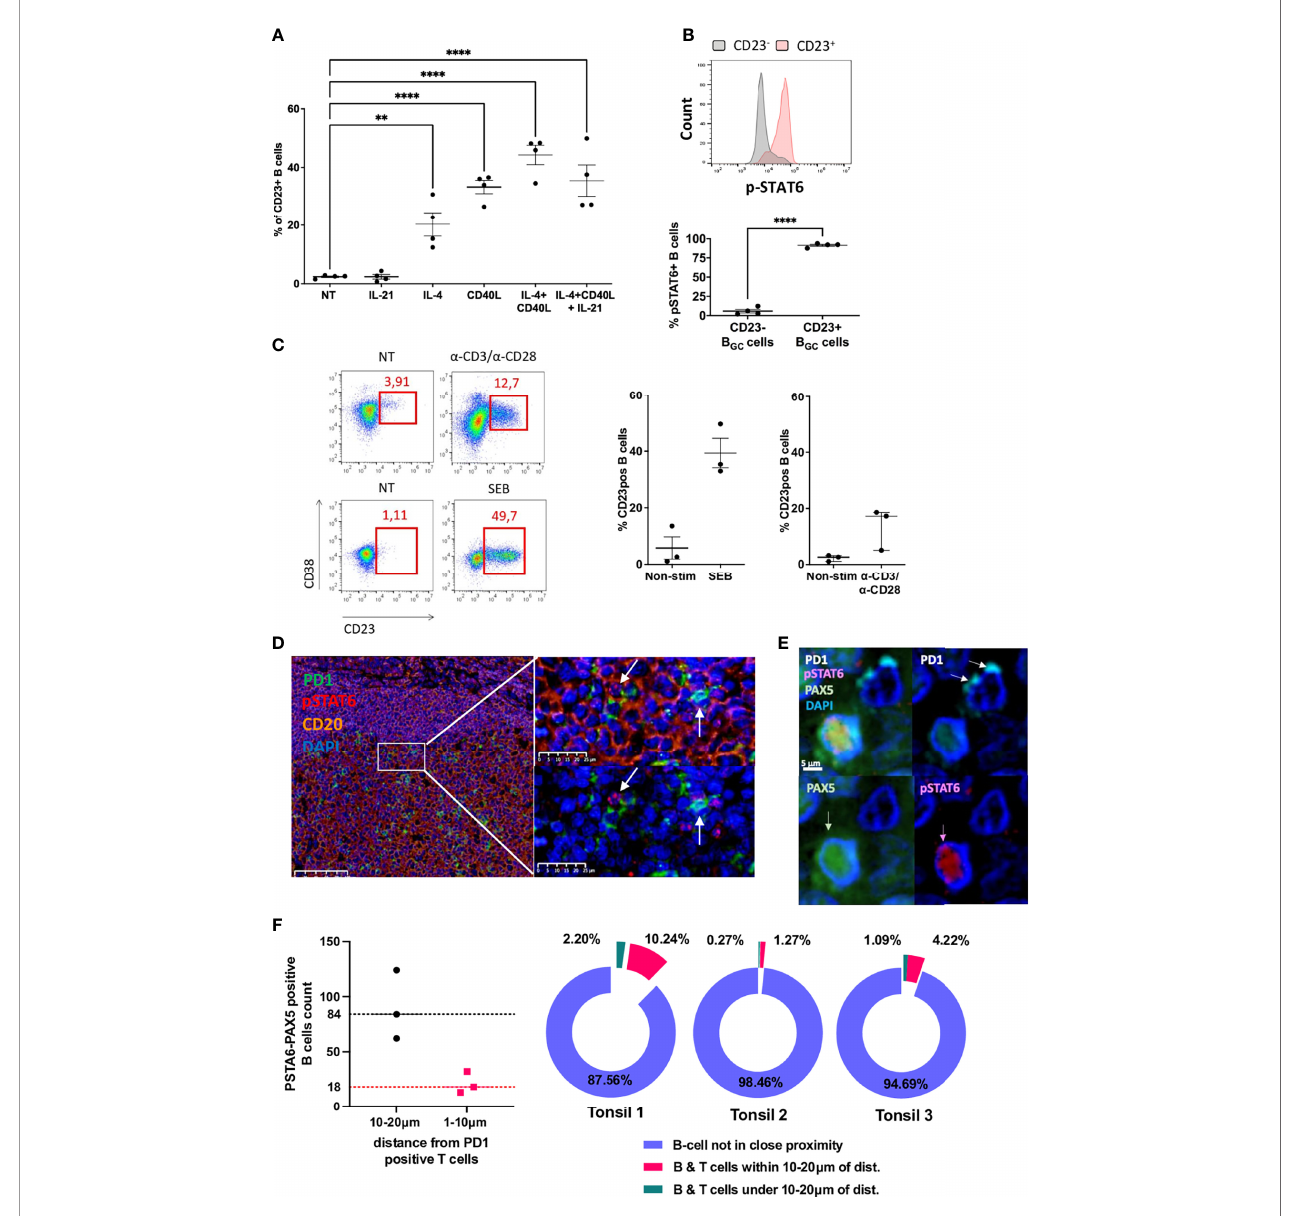
FIGURE 3 | CD23 expressionofLZB GC -cellsdependsonresponsetoTfh-drivenstimulation. (A) FlowcytometryanalysisofCD23 + LZB GC -cellsobtainedafter 12hofculture withIL-4,CD40LandIL-21aloneor incombinations(** P < .01;**** P < .0001; one-waymultiplecomparisonstest). (B) Flow cytometryanalysis ofpSTAT6inductiononpost- stimulationCD23 + andCD23 - LZB GC -cells, infourindependentexperiments: Upper panel,arepresentative fl owhistogram;Lower panel,quantitativeandstatisticallysigni fi cant analysis. (C) LZB GC -cells andTfhcells wereco-culturedwithouttreatment(NT) or withaCD3/aCD28 or staphylococcalenterotoxinB (SEB) proteinfor 24handsubsequently analyzed for CD23 and CD38 expression, using fl ow cytometry: left panel, representative fl ow graphs; right panel, results of three independent experiments. (D) GC immunohistostaining onparaf fi n-embeddedtonsilsectionswithDAPI(blue), CD20(yellow), PD1 (green), andpSTAT6(red) presentingtwohighmagni fi cationviews,showing pSTAT6 + BcellsintheproximityofPD1 + Tfhcells(whitearrows). (E) AnimagecompatiblewithacognateBcell-TfhcellcontactcharacterizedbypSTAT6 + Bcellincontactwith PD1 + Tfhcell; immunohistostainingonparaf fi n-embeddedtonsilsectionswithDAPI(blue), PAX5 (green),PD1(white), andpSTAT6(red). (F) Number ofpSTAT6-PAX5positive cells inthreetonsils inthevicinityofPD1-positiveT cells(leftpanel) andproportionofBcellsclosedtoT cells